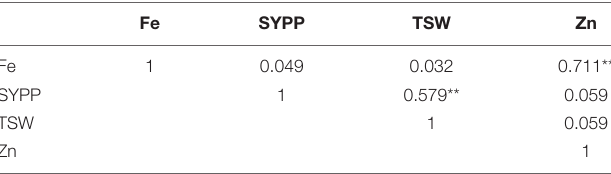
Fe, SY, TSW, and Zn are Grain iron content in mg/kg, Seed yield per plant in g, thousand seed weight in g, and Grain zinc content in mg/kg. **Significance at p < 0.01.